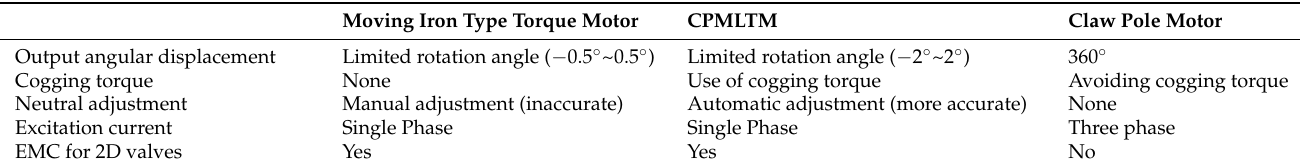
Table 1. Function comparison